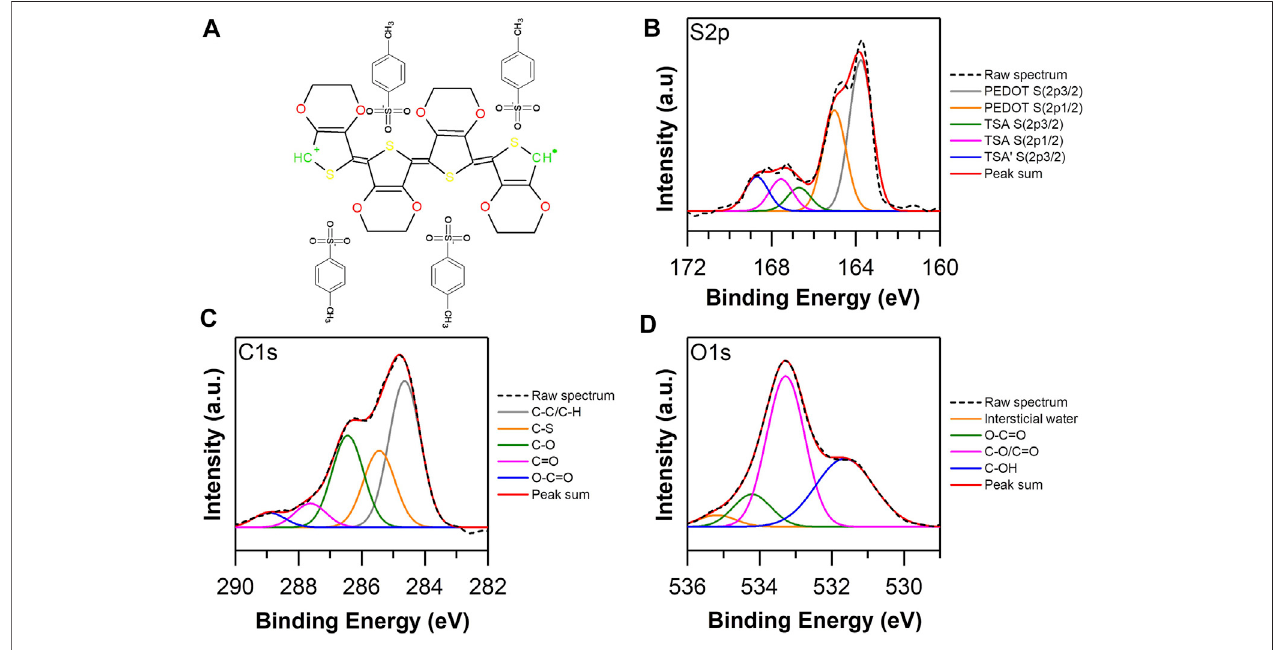
FIGURE 6 | (A) Structure of PEDOT: TSA. High resolution XPS spectra of biomimetically synthesized PEDOT TSA: (B) S 2p, (C) C 1S and (D) O 1s.